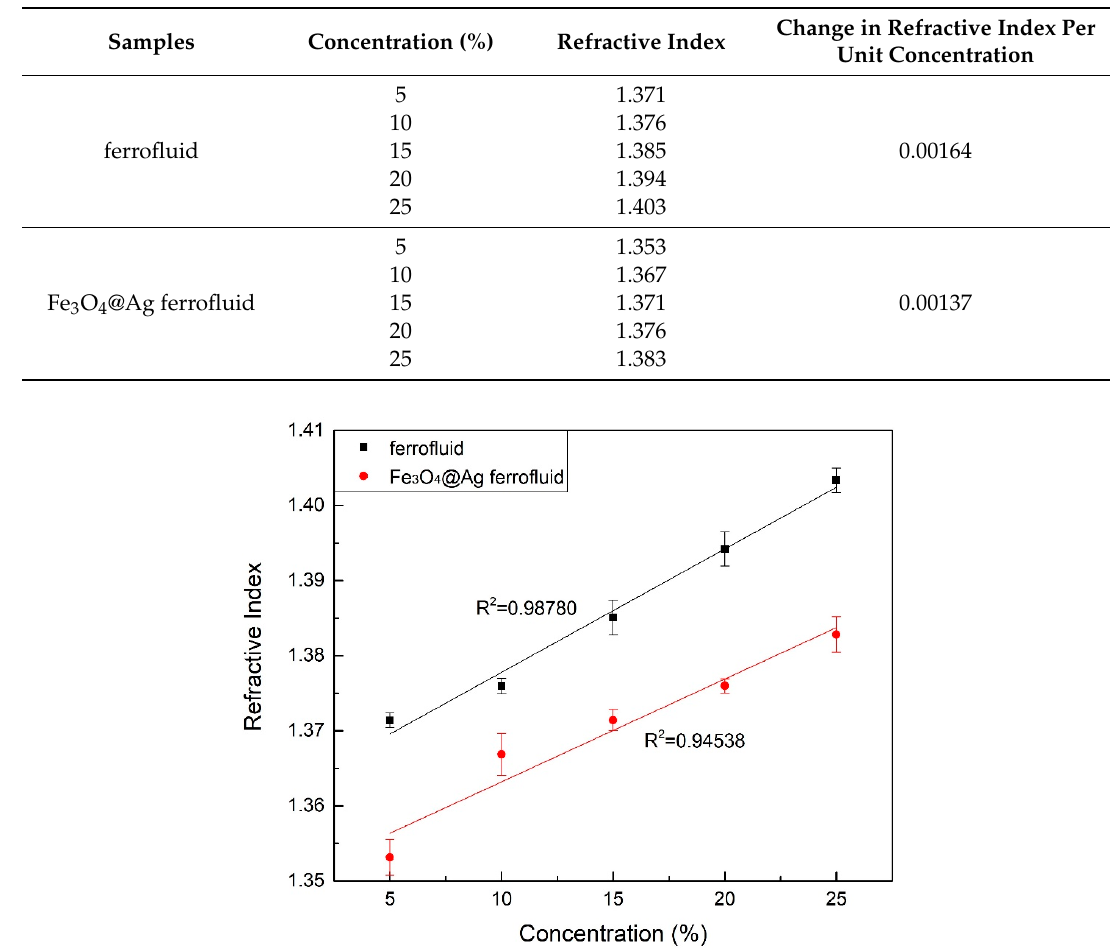
Figure 9. Fitting curves of the refractive index of these two ferrofluids.